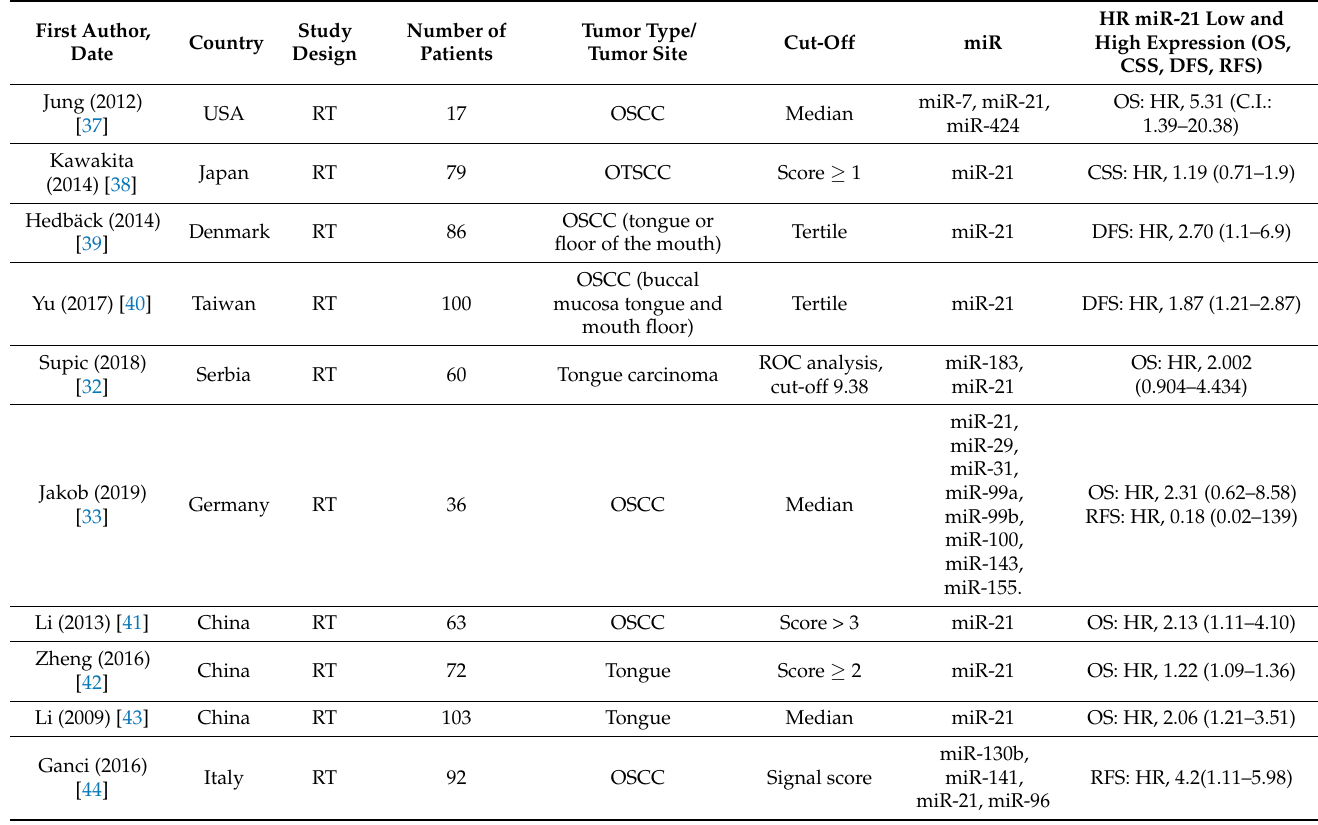
Table 1. Main data extracted from the studies.